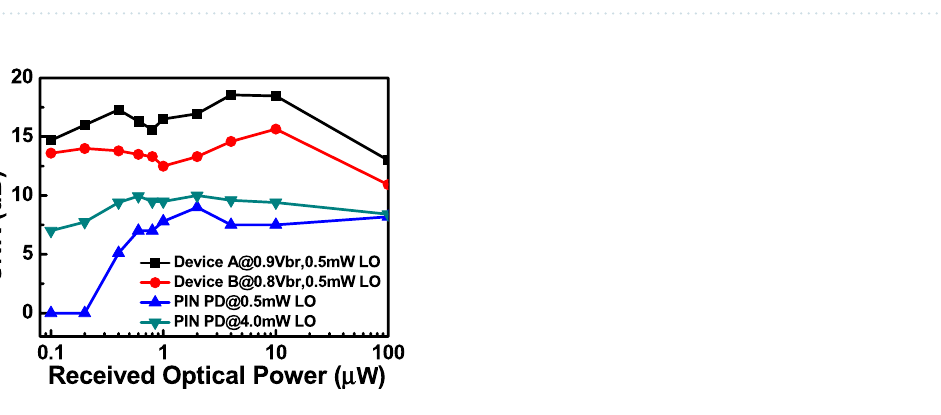
Figure 13. Measured IF spectra of p-i-n PD module with different received powers under ( a ) 0.5mW ( b ) 4mW optical LO power.